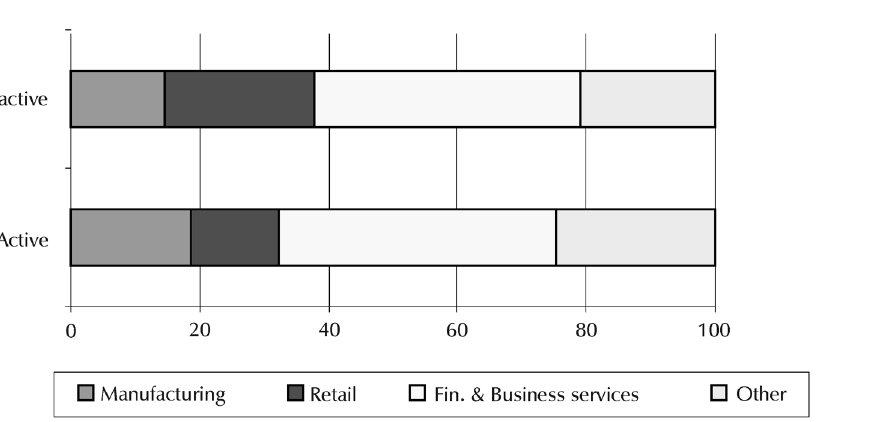
Source: Statistics South Africa,